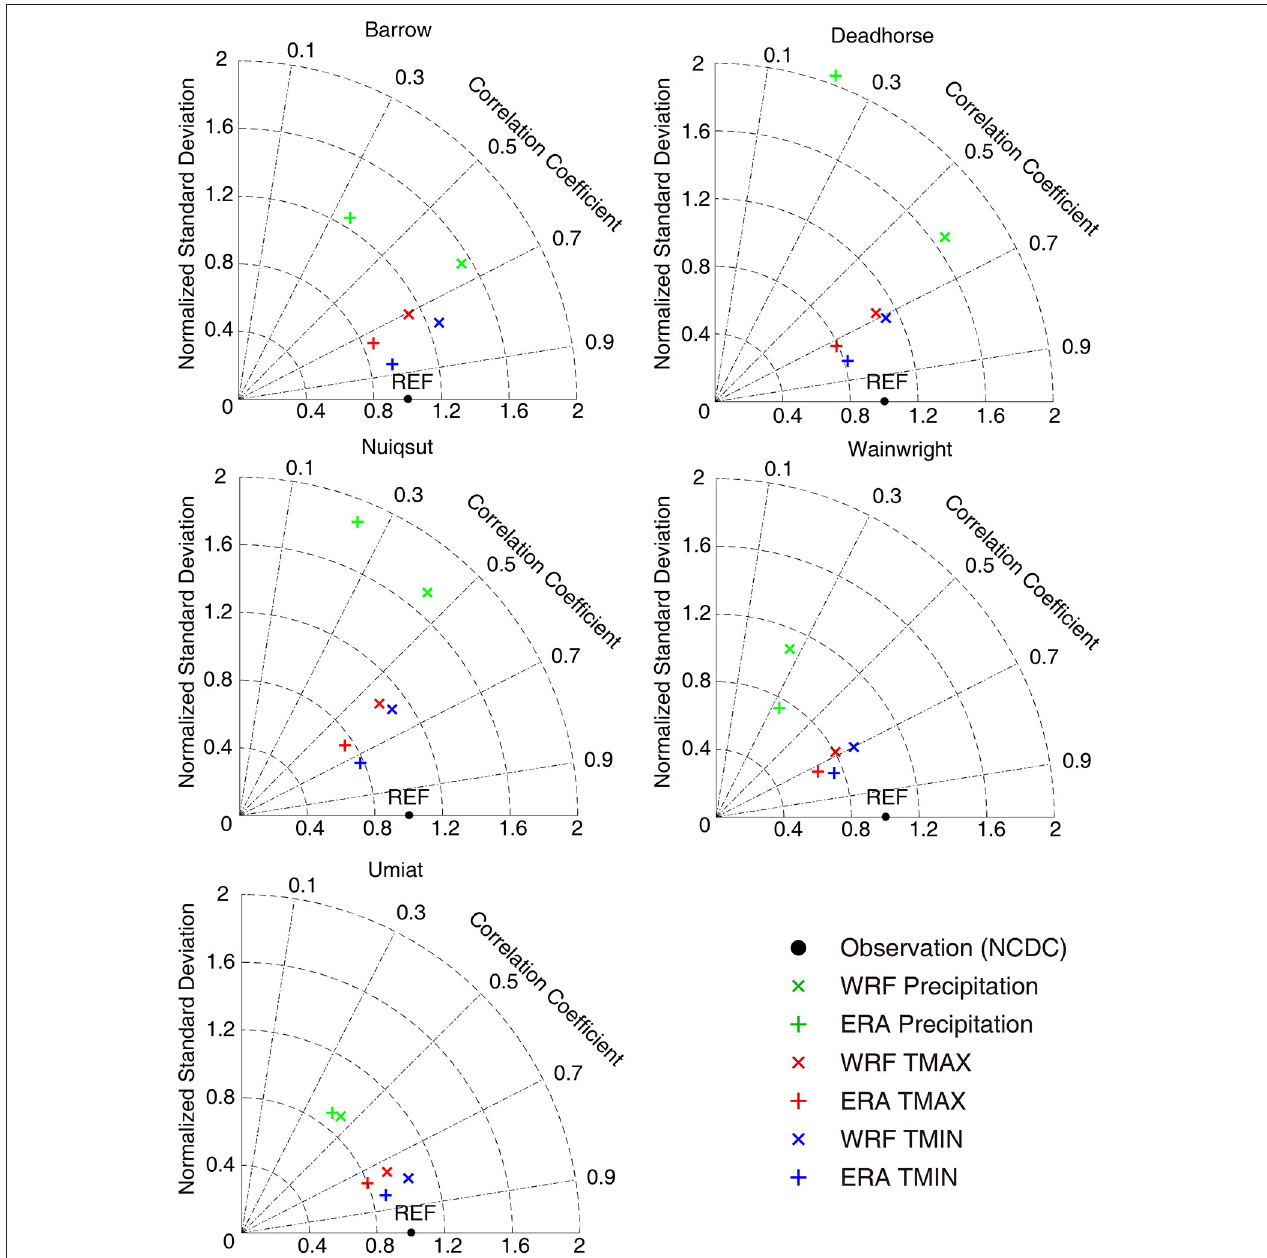
FIGURE 5 | Taylor diagram with correlation coefficients and normalized standard deviations. The baseline values are NCDC GHCN-D observations (black reference dot). Shown are daily precipitation (green), daily maximum temperature (TMAX, red), and daily minimum temperature (TMIN, blue) in ERA-interim (ERA) and downscaled ERA-WRF (WRF) products. The annual cycles of each variable have been removed before calculating the correlation coefficients and standard deviations.